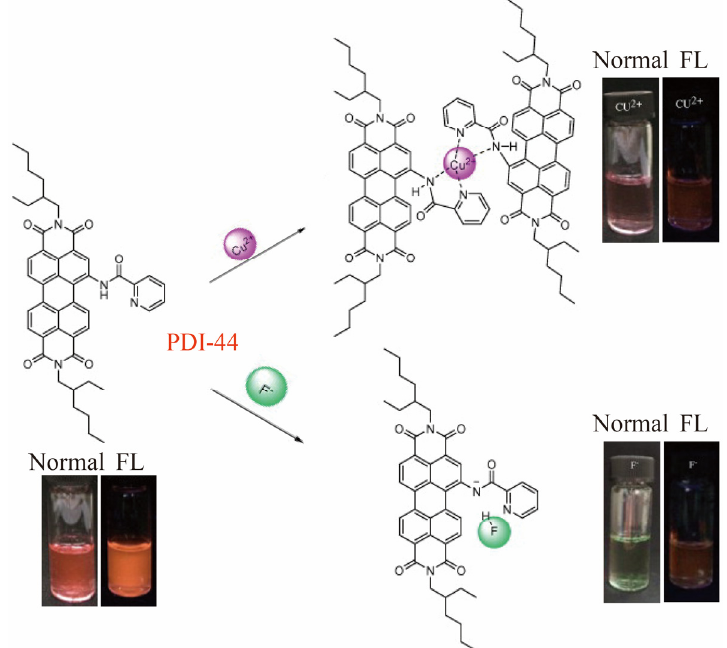
Figure 15. Schematic illustration of the sensing mechanisms of PDI-44 towards Cu 2 + and F − ions, also shown are the photographs of the corresponding solutions before and after adding ions, taken under natural light and UV illumination. Adapted and reproduced with permission from [61] copyright 2014 Elsevier B. V.